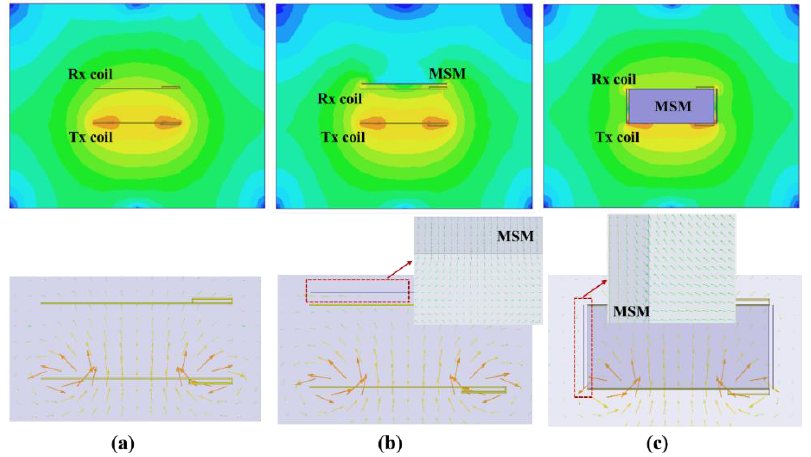
Figure 6. Magnetic field distribution of the MSM on the top of the EV: ( a ) without the MSM ( b ) with the MSM on the top, and ( c ) with the MSM on the side.